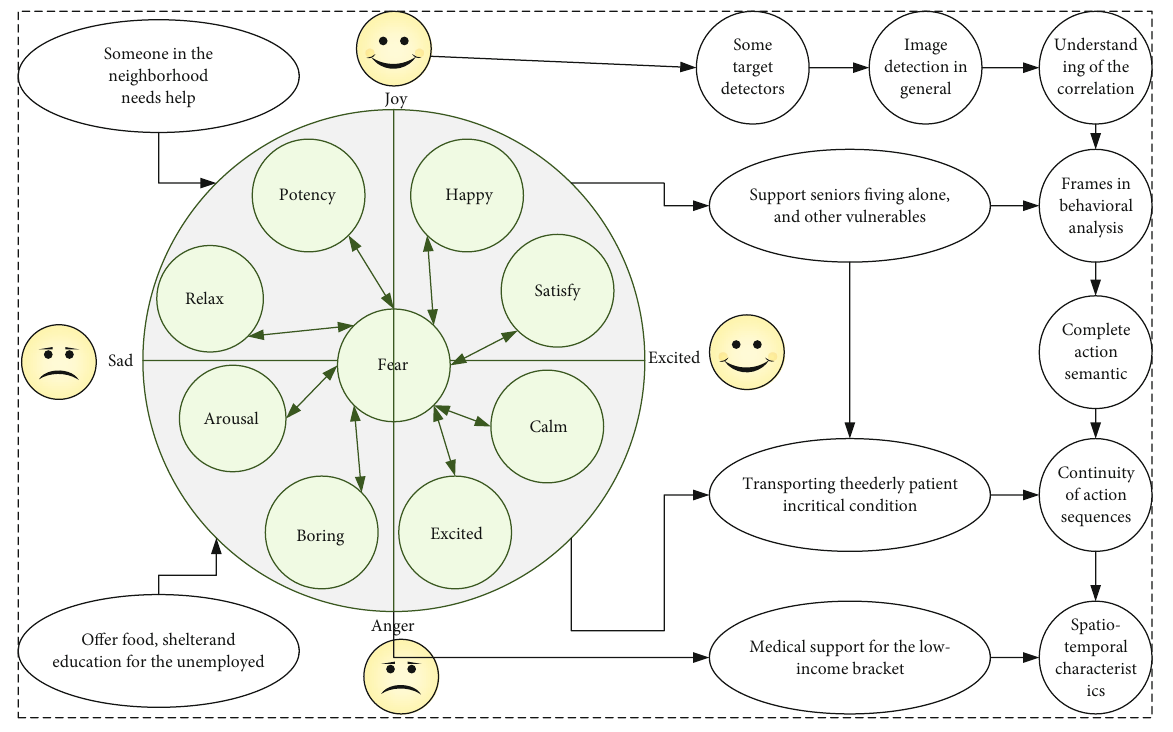
Figure 1: Valence and arousal degree.